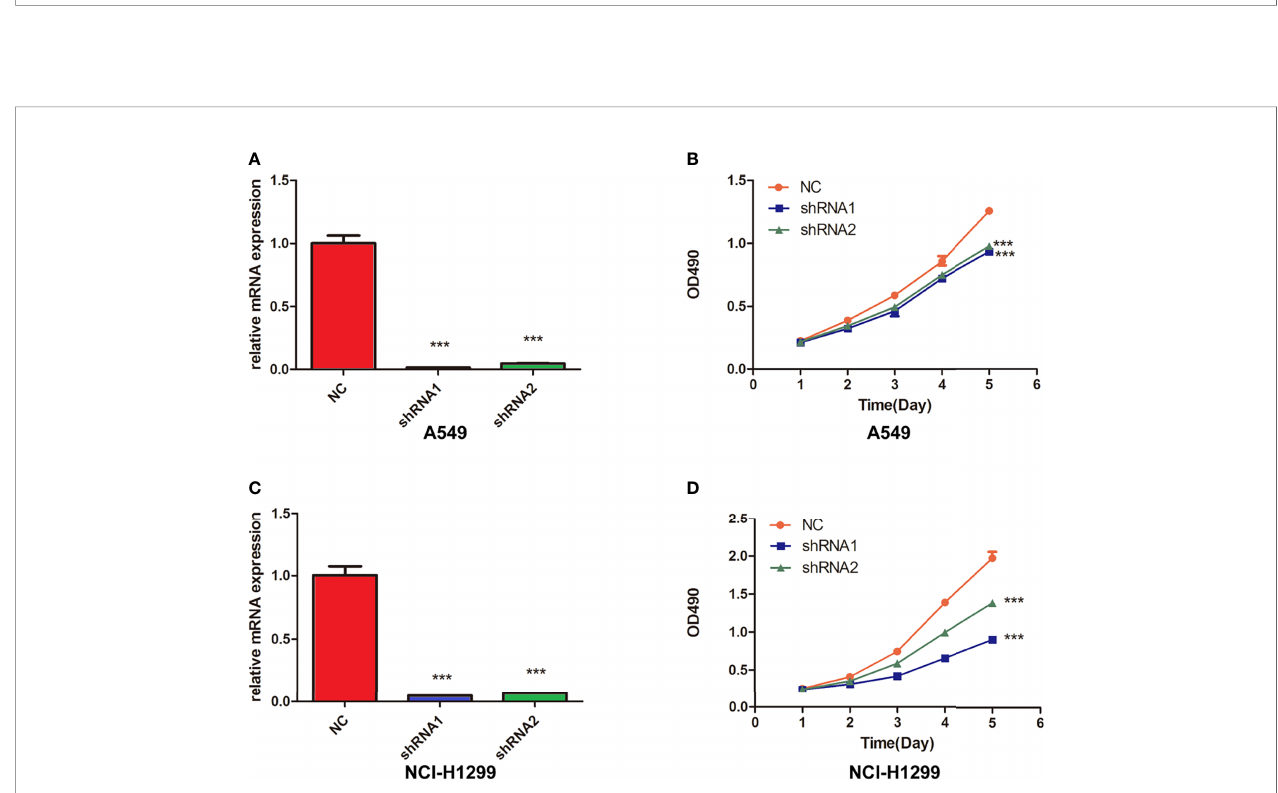
FIGURE 9 | GSEA of FUCA2 in TCGA pan-cancer. (A – F) The top 20 signi fi cant pathways of FUCA2 GSEA results across the indicated tumor types. Red color represents immune-related pathways.